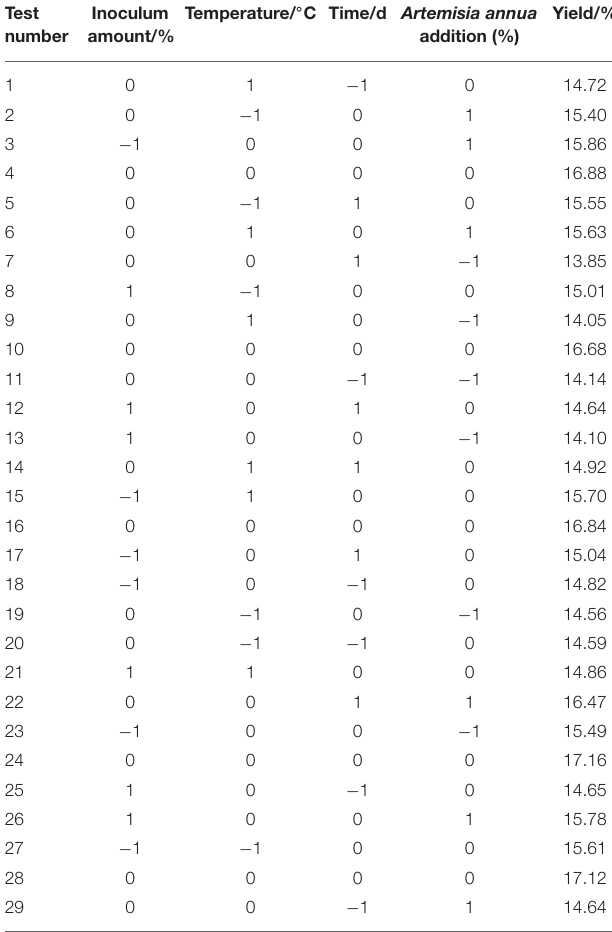
TABLE 2 | Response surface test design and